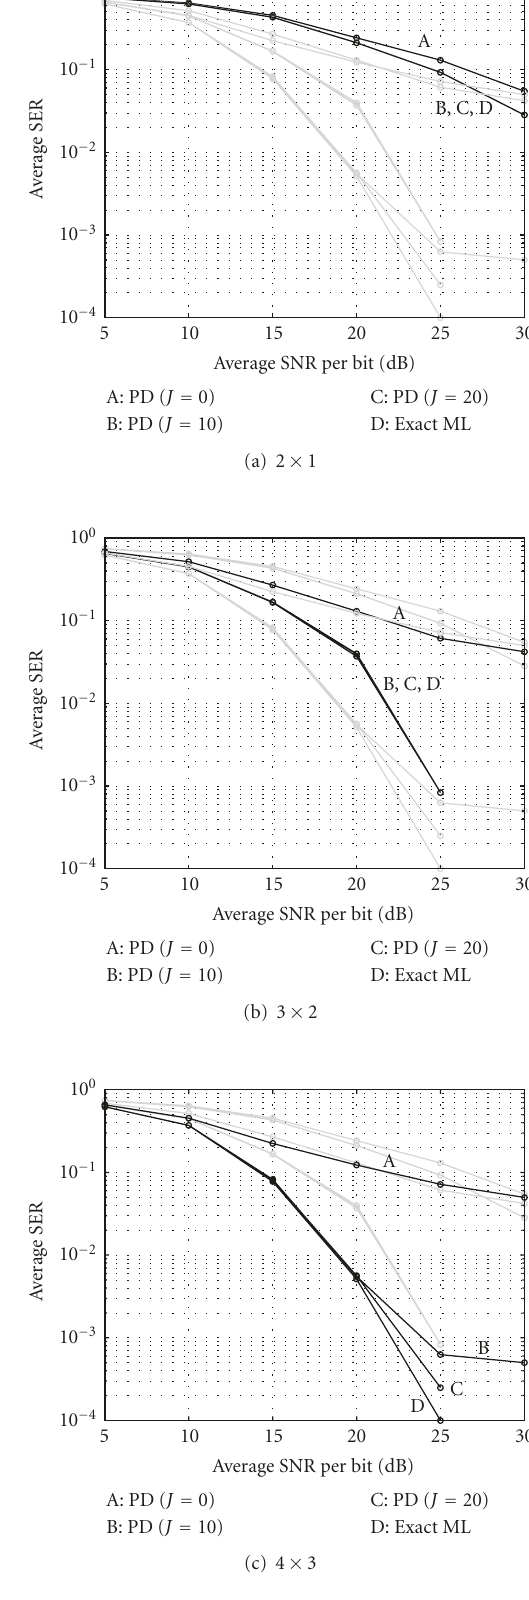
Figure 10: The average SER performance versus the average SNR per bit for 16-QAM